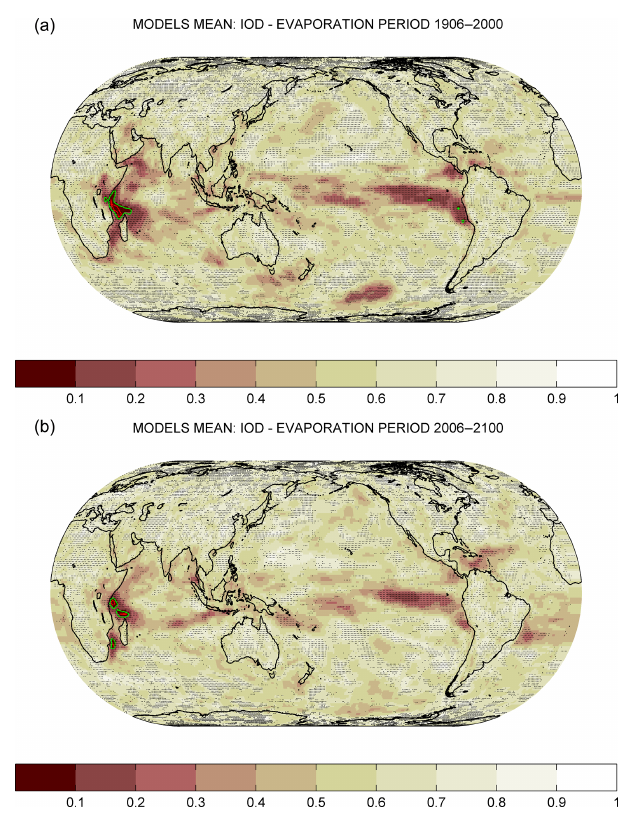
Figure 2. As in Fig. 1 but for Granger causality between the IOD and annual mean evaporation. IOD: Indian Ocean